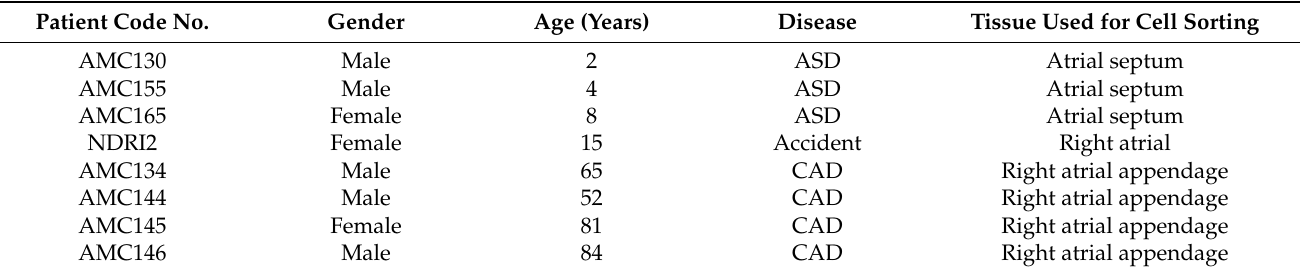
Table 1. Patients’ basic demographics for established pediatric and adult hMPCs lines used in this